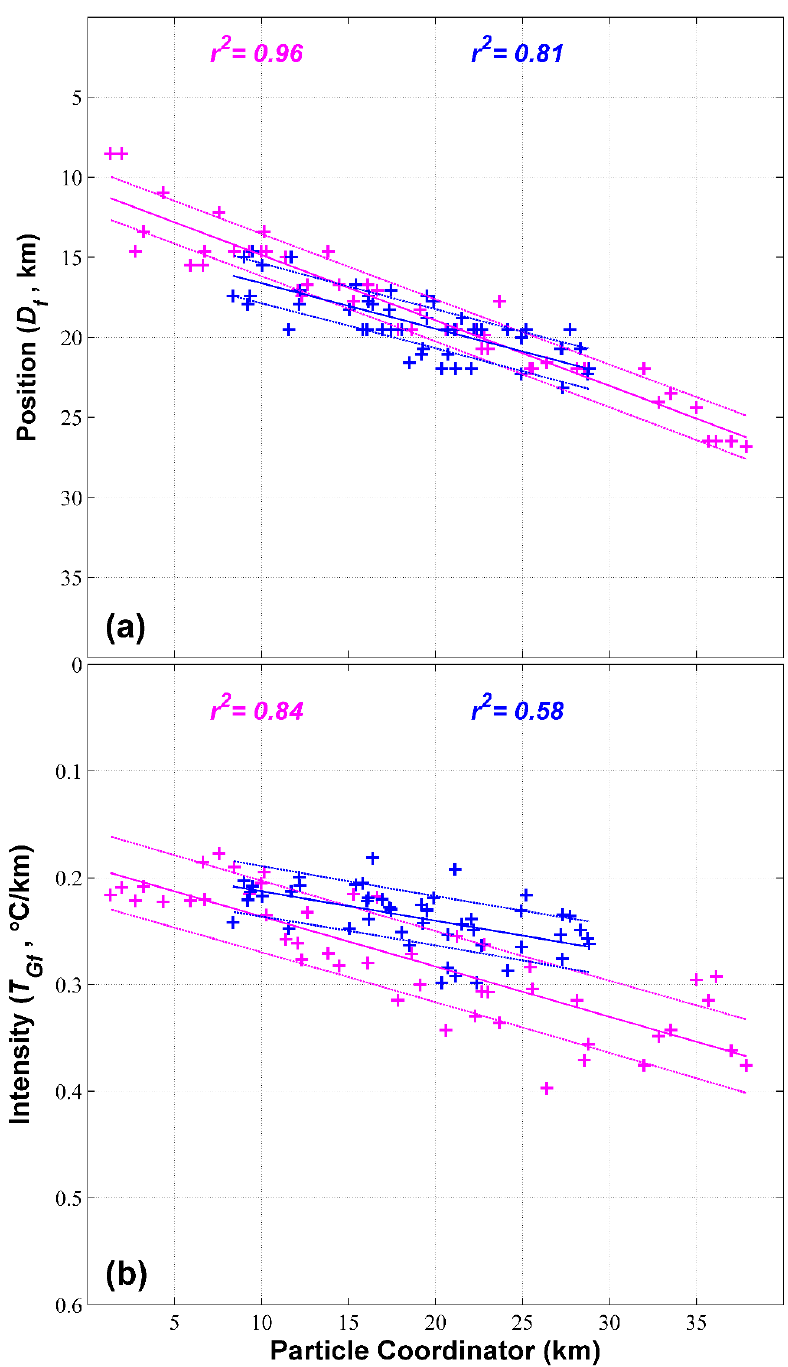
Figure 5. Lag correlations between the particle coordinator calculated by the predicted tidal current velocity using Equation (2) and ( a ) front position ( D f , distance between the point denoted by a star in Figures 3 and 4 and the center of the strait), and ( b ) front intensity ( T Gf , magnitude of the SST gradient at the point denoted by a star in Figures 3 and 4). Pink and blue plus symbols represent the spring tide (Figure 3) and neap tide (Figure 4) values, respectively. Pink (blue) r 2 means the correlation coefficient at spring (neap) tide when the particle coordinator lags behind the tidal front position by one (one and half ) hour.